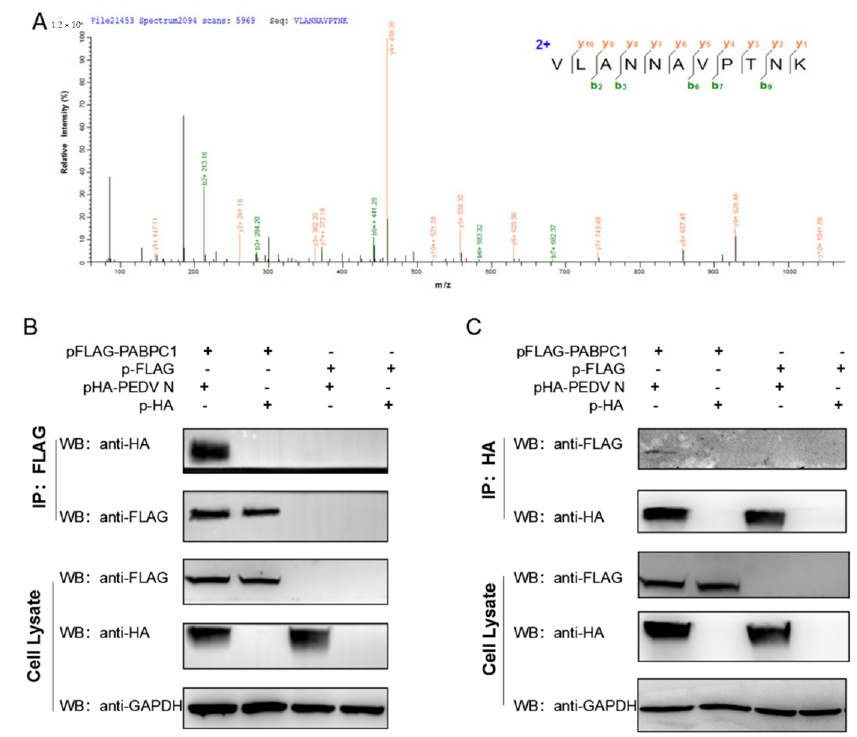
Figure 4. PABPC1 interacts directly with PEDV N protein. ( A ) Mass spectrum data of the potential PABPC1-interacting proteins in PEDV-infected Vero cells. ( B ) Co-immunoprecipitation assay with FLAG-tag antibody in 293T cells after transfection with pcDNA3.1(+)-FLAG-PABPC1 and pcDNA3.1(+)-HA-PEDV-N. ( C ) Co-immunoprecipitation assay with HA-tag antibody in 293T cells after transfection with pcDNA3.1(+)-FLAG-PABPC1 and pcDNA3.1(+)-HA-PEDV-N.